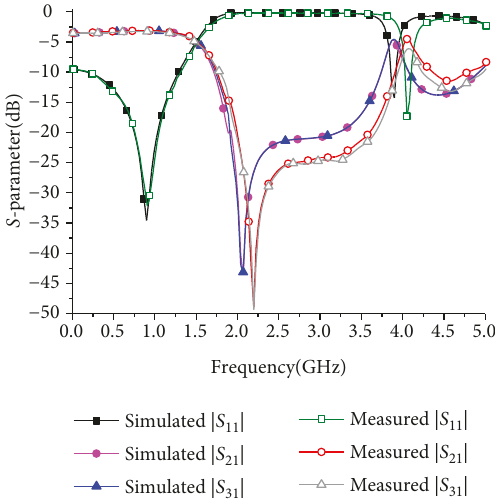
Figure 10: Simulated and measured S proposed Wilkinson power